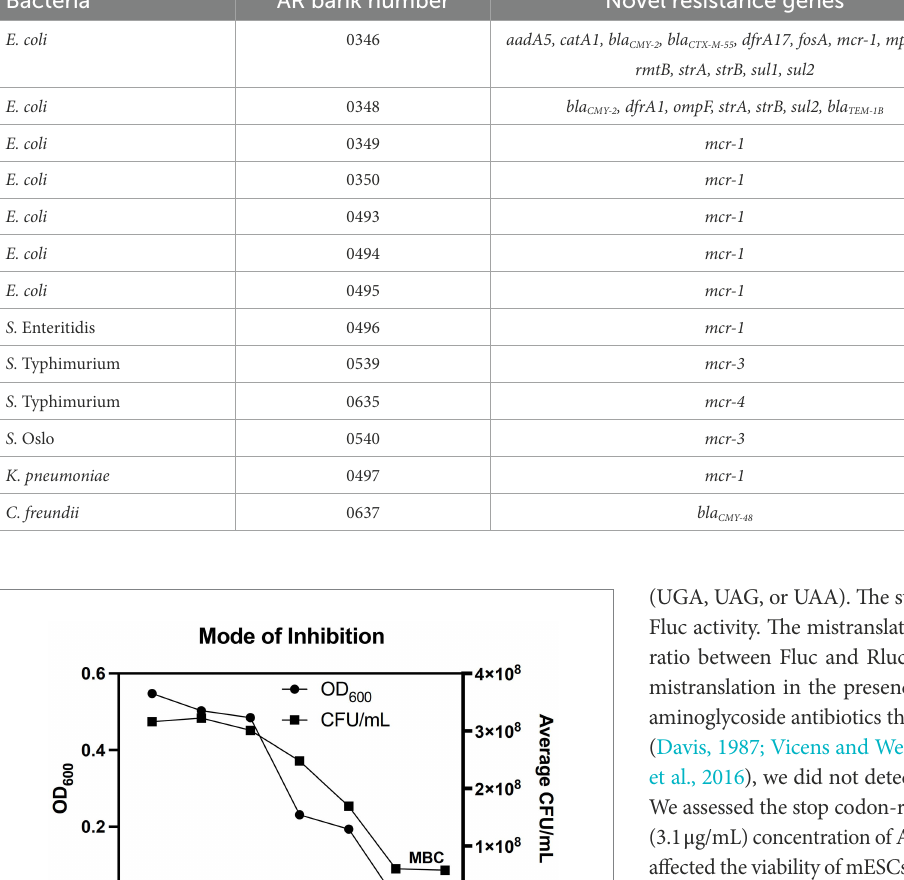
TABLE 1 AgNPs have antibacterial activity against clinical isolates with new and emerging resistance genes. Bacteria